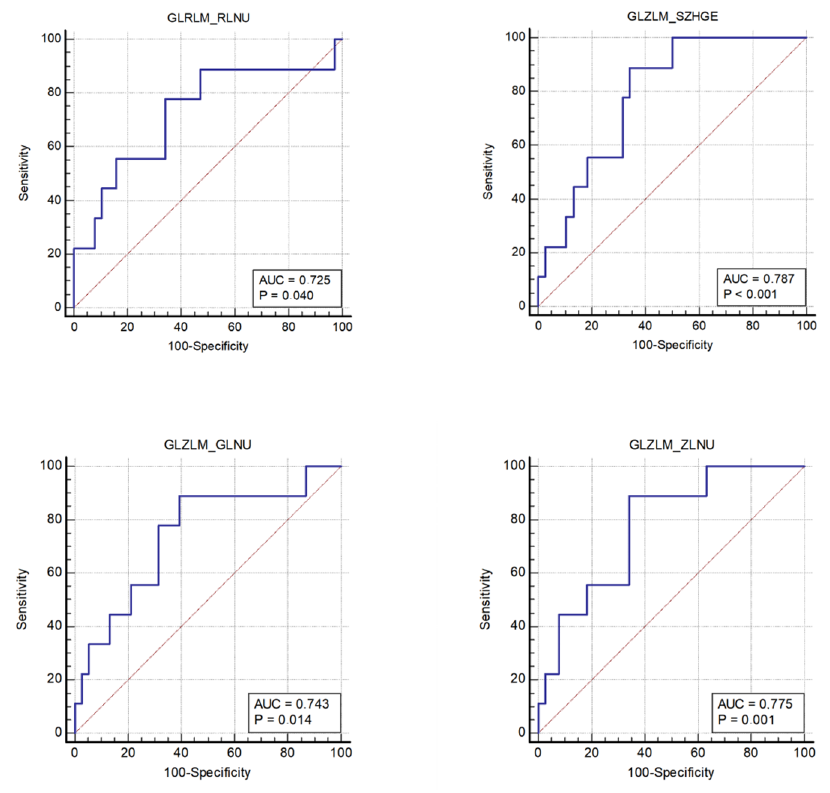
Figure 3. The microsatellite status with ROC curves of the 4 significant CT-TA parameters. Table 3. Microsatellite status—significant